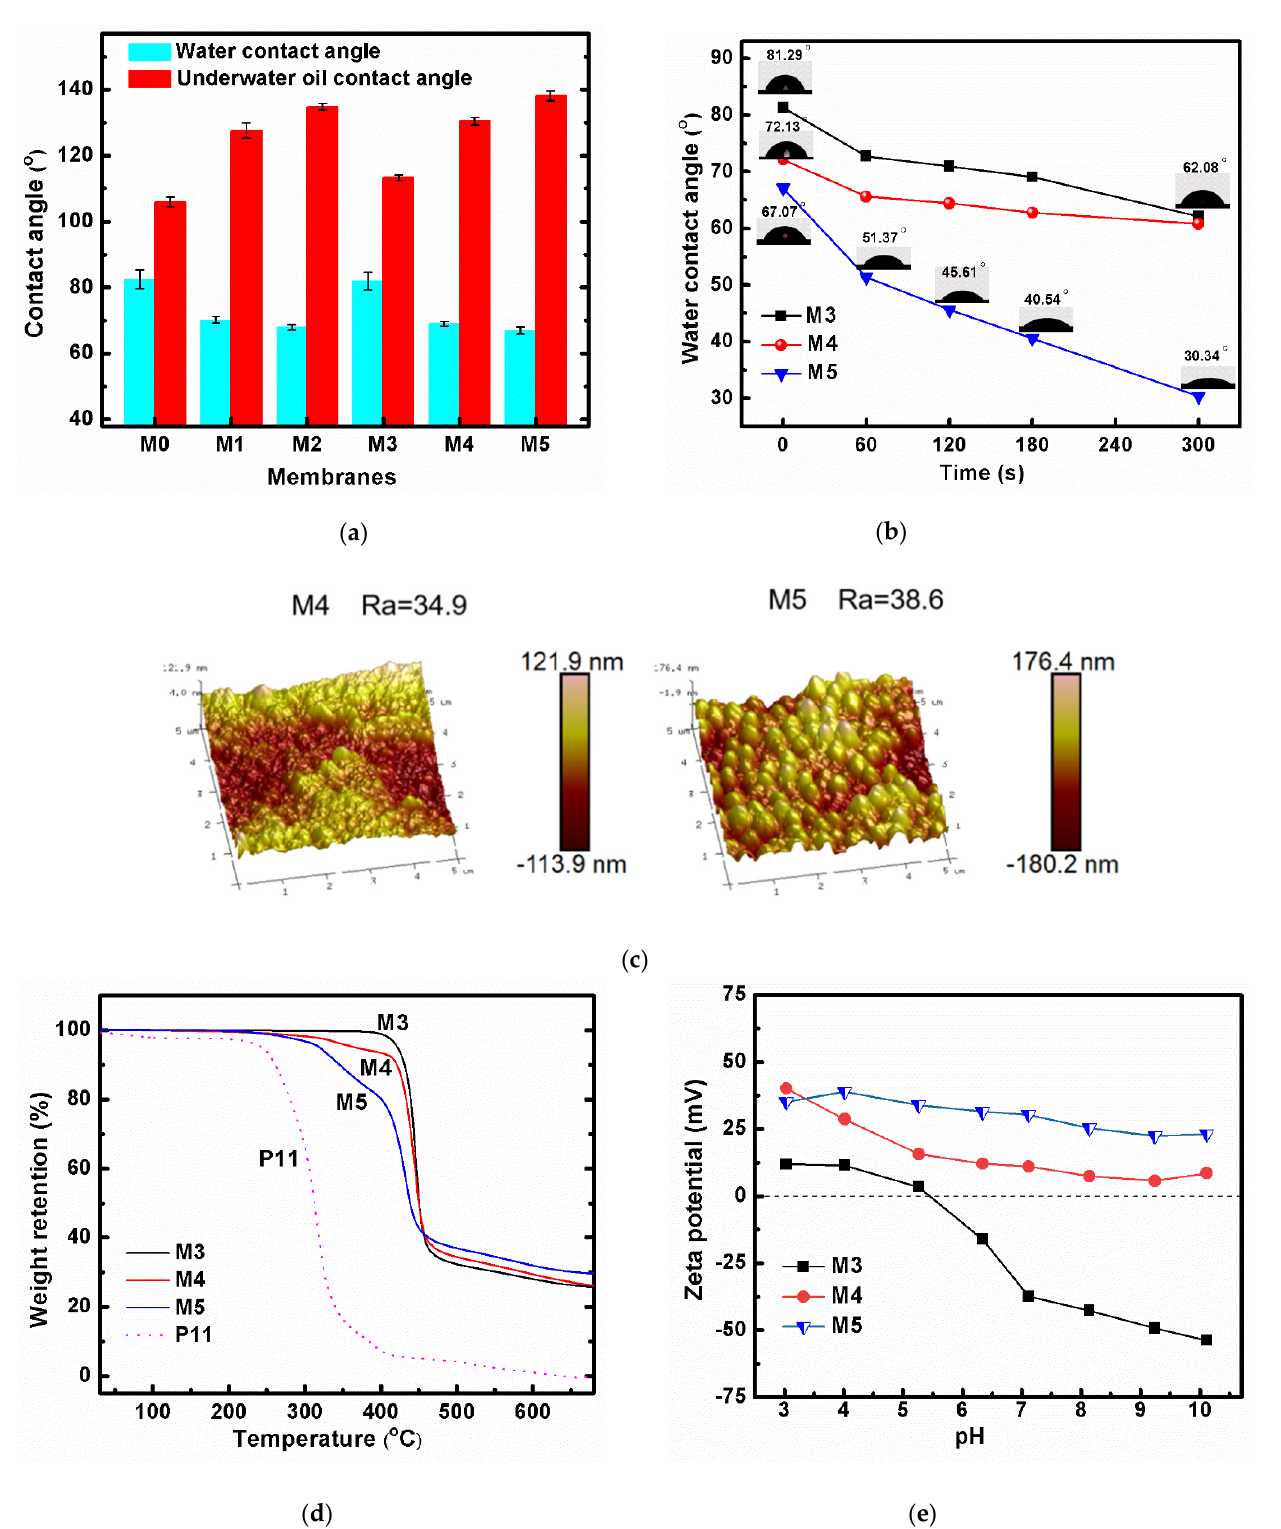
Figure 4. ( a ) The static water/underwater oil contact angles of all membranes; ( b ) the dynamic water contact angles of membranes M3, M4, and M5; ( c ) AFM images of blend membranes M4 and M5; ( d ) TGA diagram of the polymer P11 and membranes; and ( e ) Zeta potentials of membranes M3, M4, and M5.